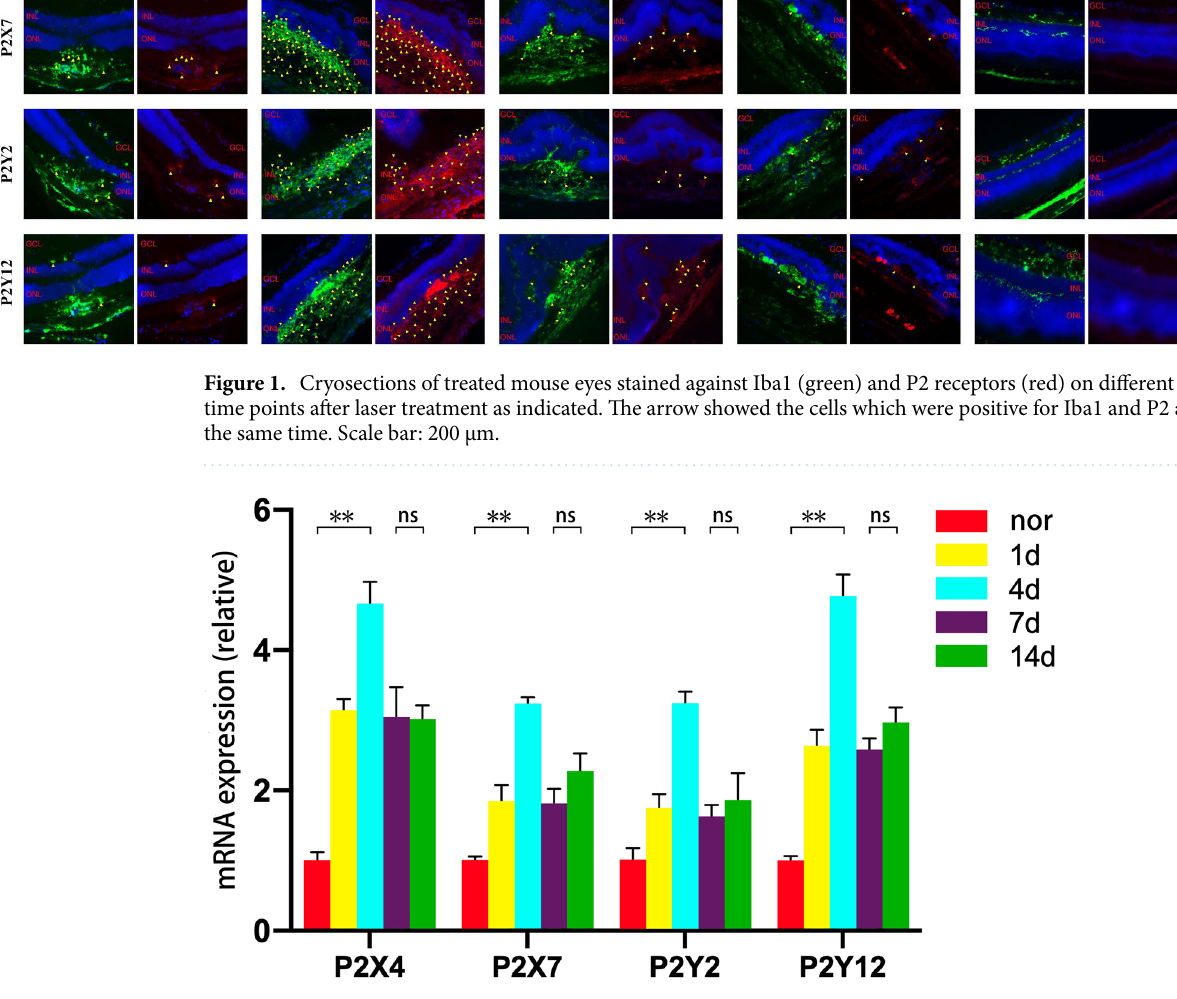
Figure 2. The expression level of P2 receptors’ mRNA on different time points after laser treatment. (**P < 0.01, ns (no significance) P >